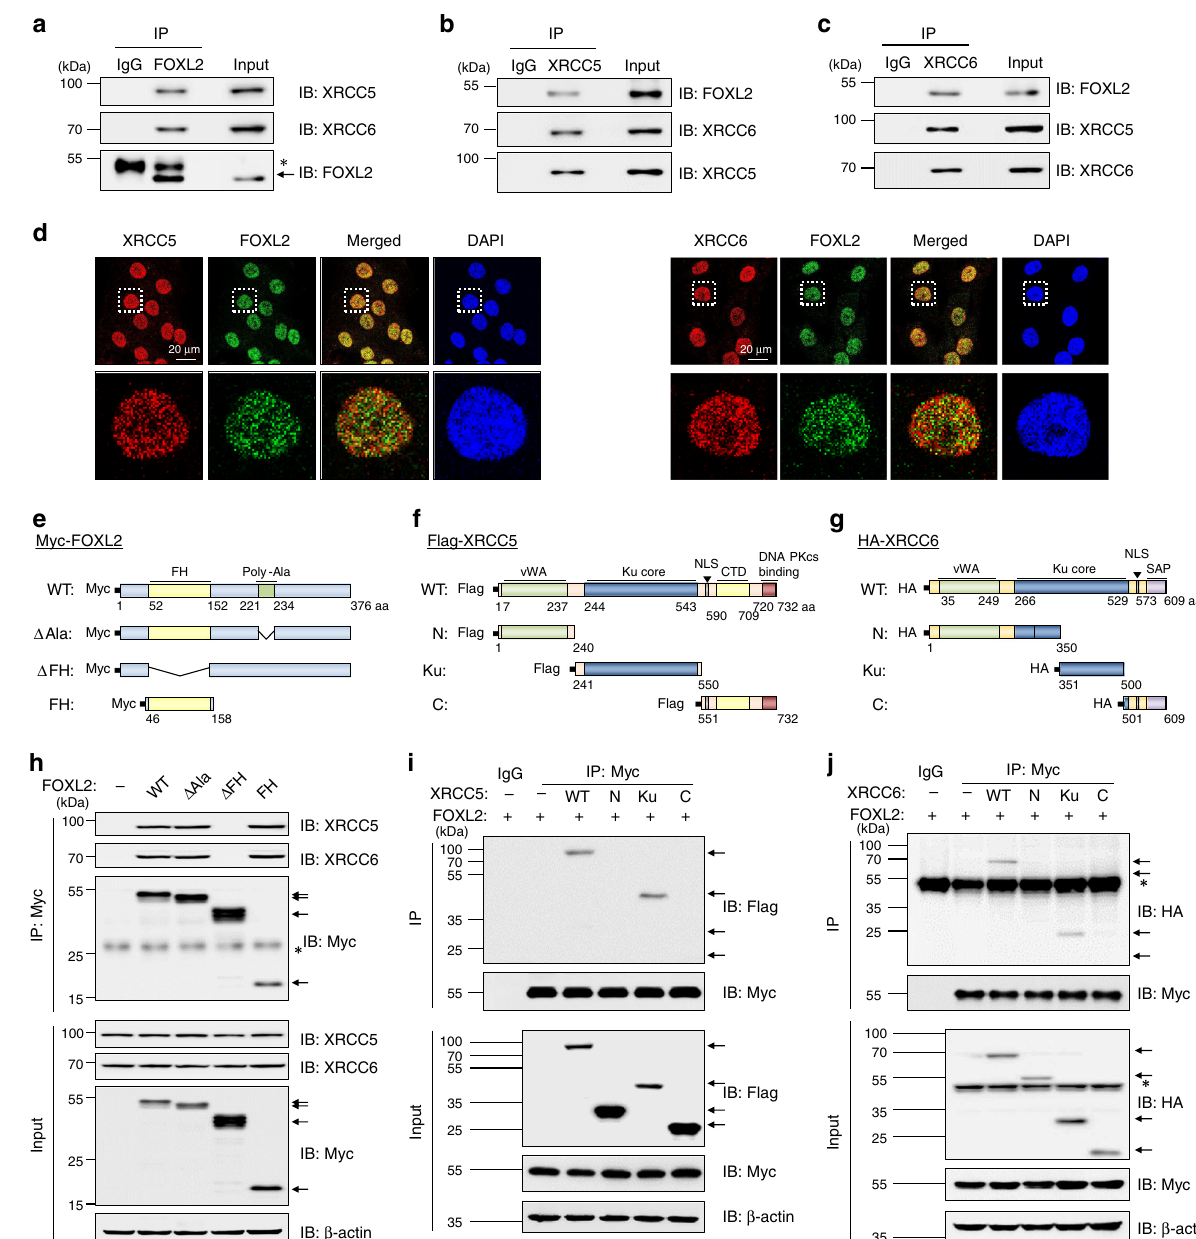
Fig. 1 FOXL2 physically interacts with XRCC5 and XRCC6. a – c Interactions between endogenously expressed FOXL2 and XRCC5 and XRCC6 proteins in KGN cells were demonstrated by immunoprecipitation (IP) with IgG (control), anti-FOXL2 ( a ), anti-XRCC5 ( b ), or anti-XRCC6 ( c ) antibody followed by immunoblot analysis with the indicated antibodies. d Nuclear colocalisation of endogenous FOXL2 protein with XRCC5 and XRCC6 in KGN cells revealed by confocal fl uorescence microscopy. The length of scale bar is 20 μ m. e – g Schematic representations of the plasmids encoding full-length (WT) and truncated mutants of FOXL2 ( e ), XRCC5 ( f ), and XRCC6 ( g ), which were generated to determine the binding domains. FH: forkhead domain; poly-Ala: polyalanine region; vWA: von Willebrand A domain; NLS: nuclear localisation signal; CTD: C-terminal helical domain; SAP: SAF-A/B, Acinus and PIAS domain. h – j 293T cells were transfected with the indicated plasmids. Cell lysates were subjected to IP with control IgG or anti-Myc antibodies followed by immunoblotting with the indicated antibodies. The arrows indicate expected positions of the respective proteins, and nonspeci fi c bands are indicated with asterisks in all panels. Source data are provided as a Source Data fi